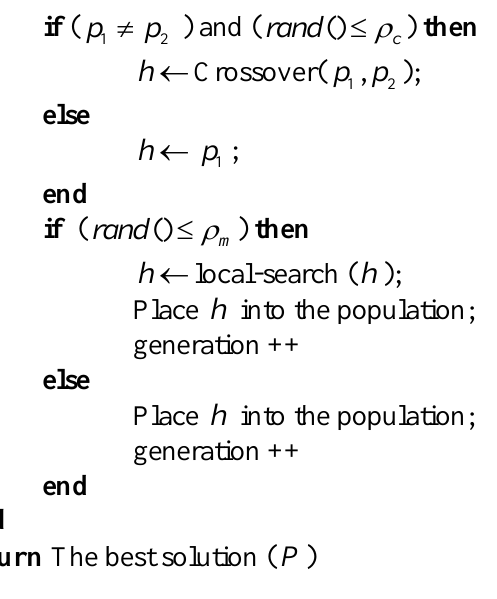
Algorithm 1 . MCBGA Pseudo